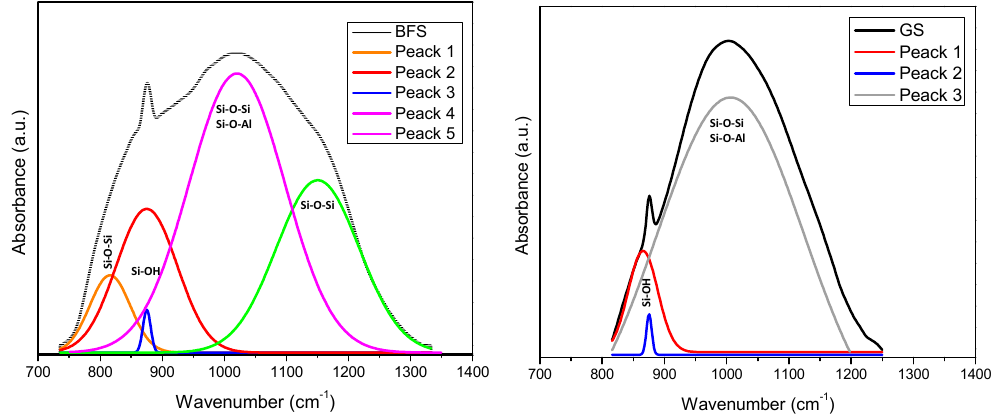
Figure 4. FT ‐ IR Spectrum deconvolution of Si ‐ O ‐ T bands of BFS and GS. Figure 4. FT-IR Spectrum deconvolution of Si-O-T bands of BFS and